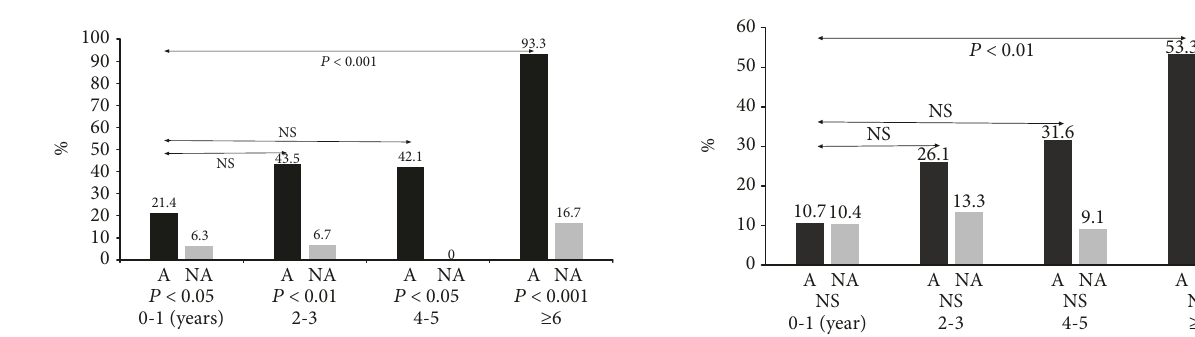
Figure 4: Positive coexisting or past allergic diseases rates (eczema, allergic conjunctivitis). A, asthma group; NA, nonasthma group. The rates of coexisting allergic diseases were signi fi cantly higher in the older age groups than in the 0 – 1-year-old age group (NS, p < 0 01